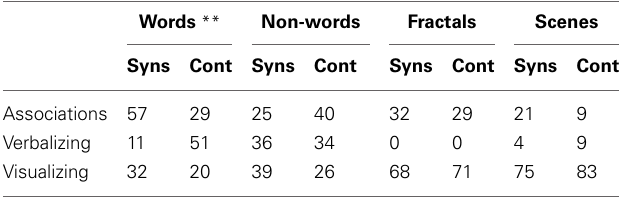
0 . 59), non-words (synaesthetes: mean = 1 . 41, SD = 0 . 73; con-